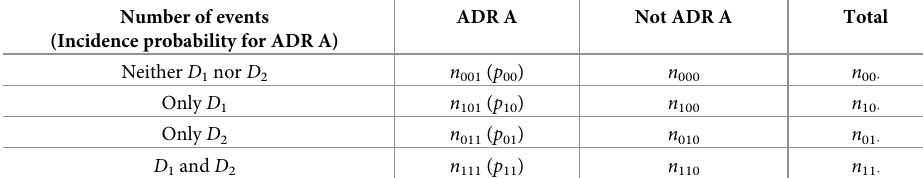
Table 1. Four-by-two contingency table for DDI evaluation. Number of events (Incidence probability for ADR